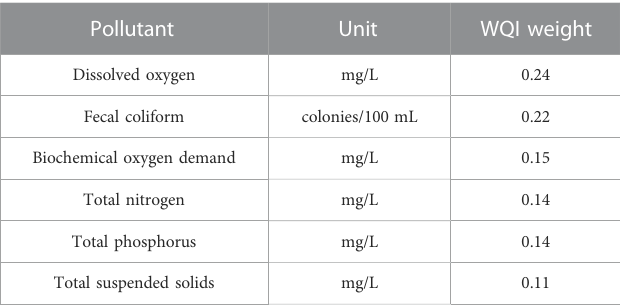
TABLE 3 Water quality index (WQI) subindex